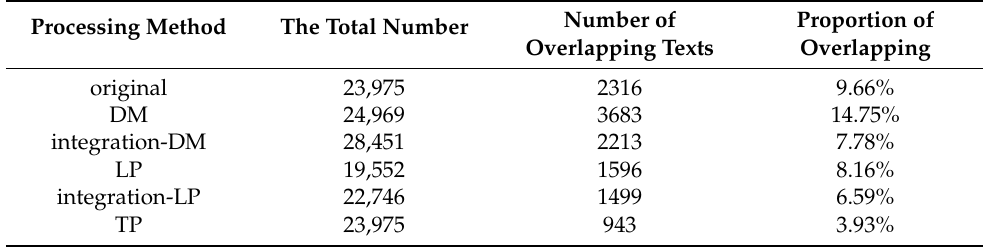
Table 9. Class overlap situation.